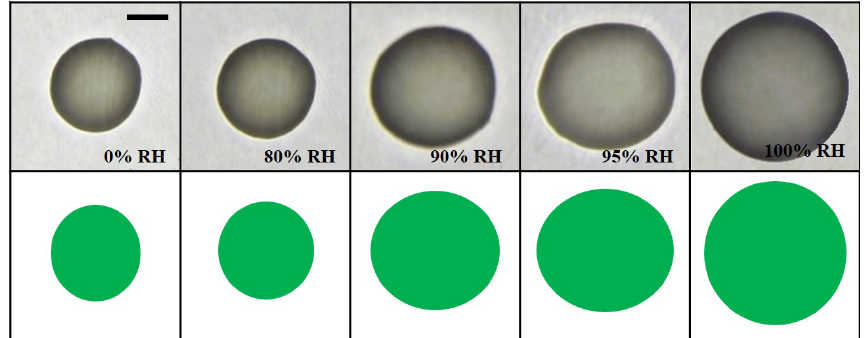
Figure 2. Optical images of a SOA particle produced from α -pinene photooxidation ( α -pinene OH no. 2 in Table 1) with increasing RH. The purpose of the illustrations is to clarify the images. Green is the SOA-rich phase, and blue is the water-rich phase. The scale bar is